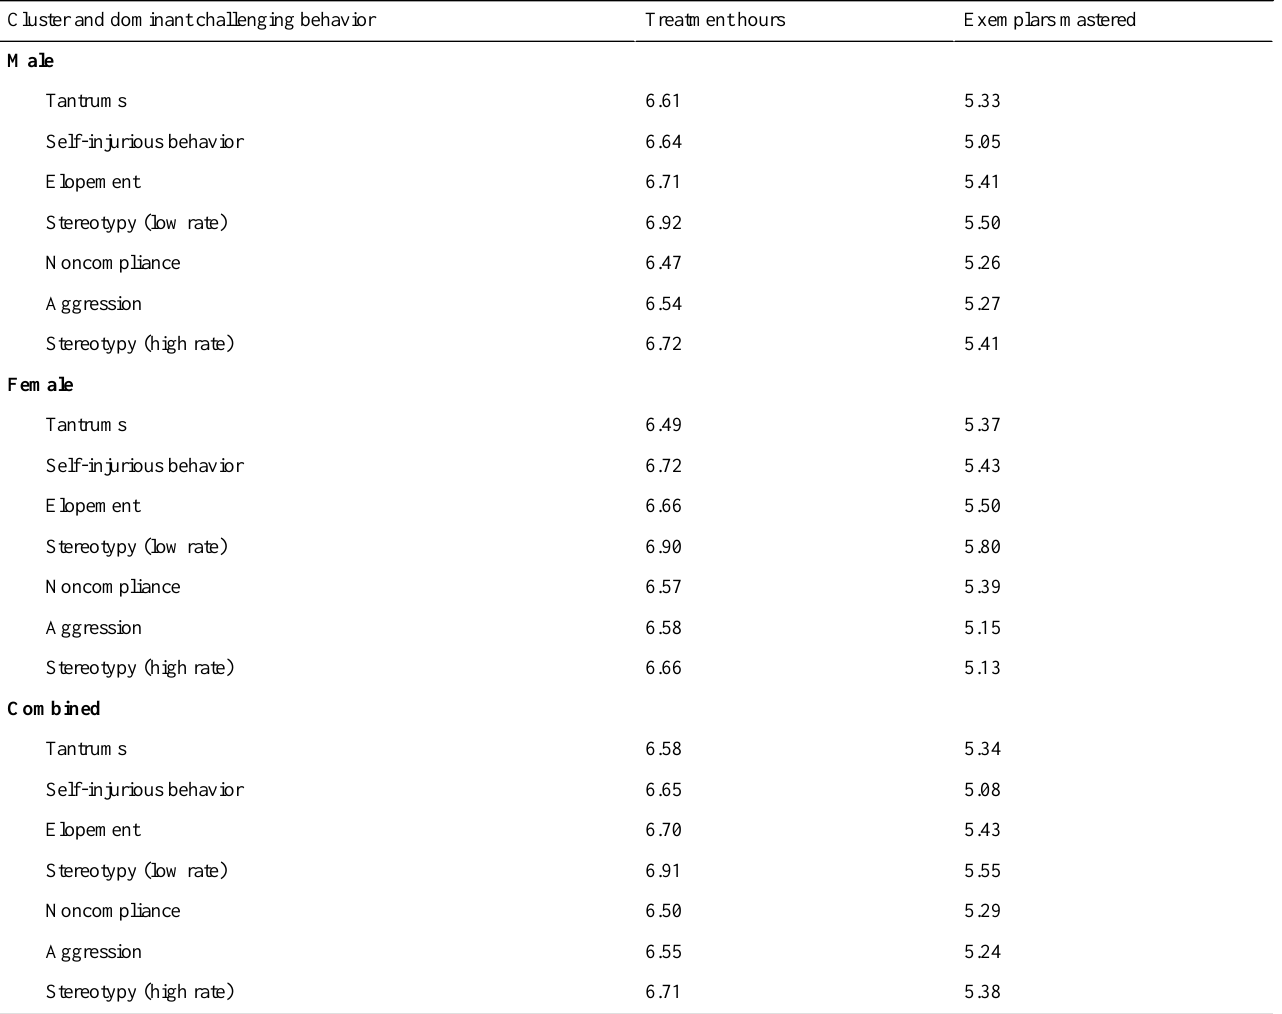
Table 4. Average treatment hours and exemplars mastered across male, female, and combined gender